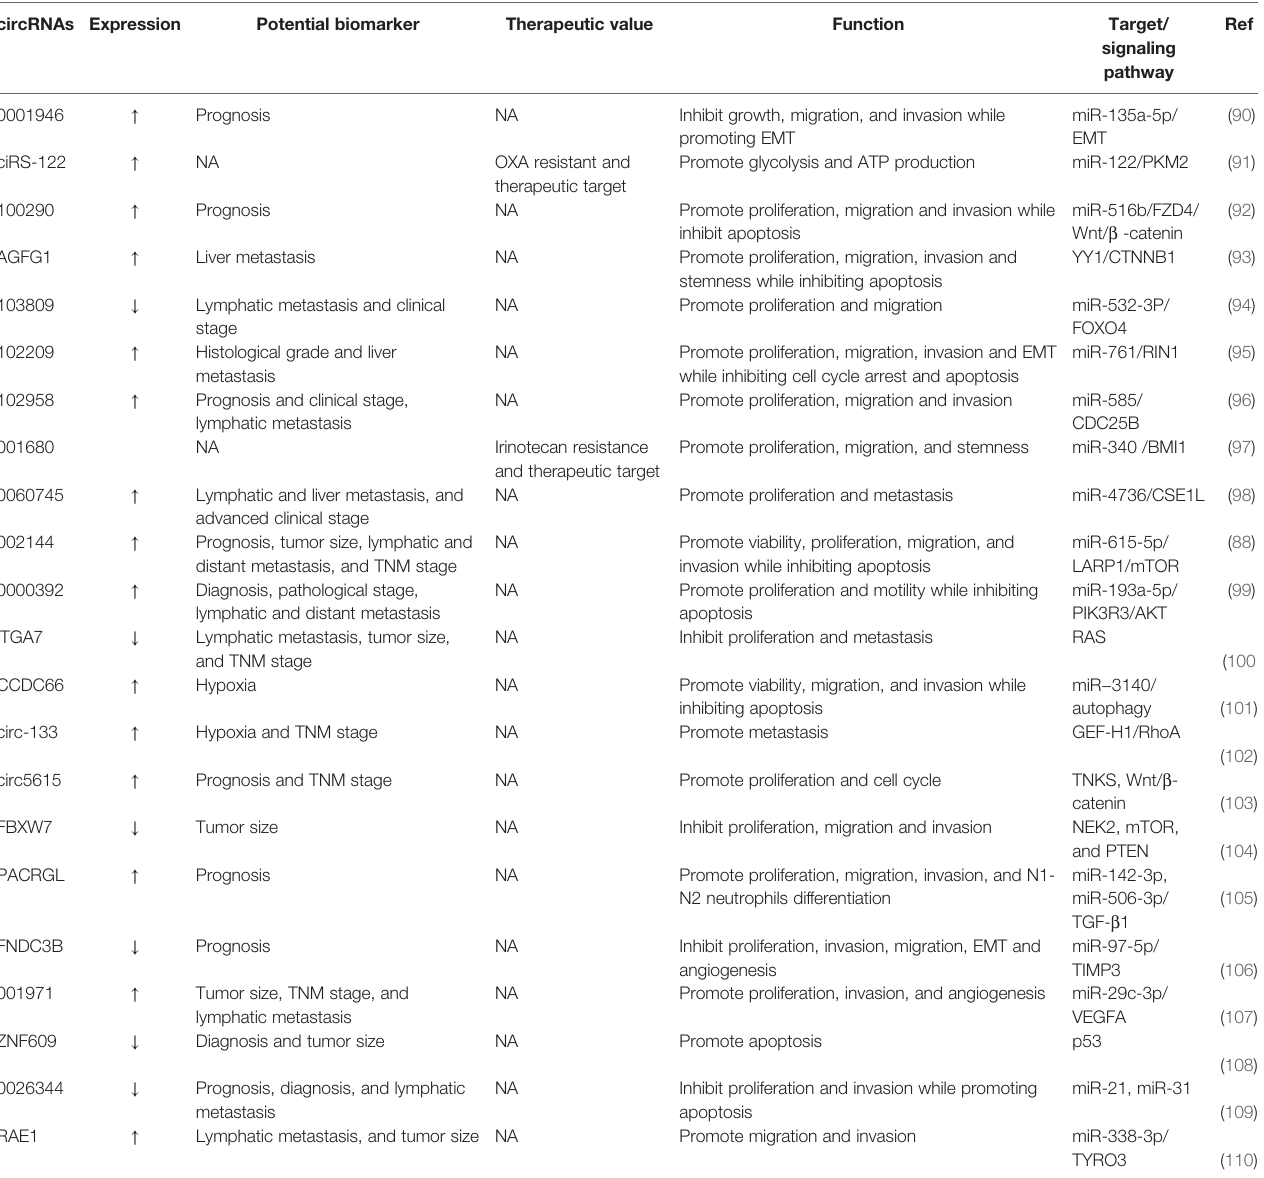
TABLE 3 | Selected examples of regulatory